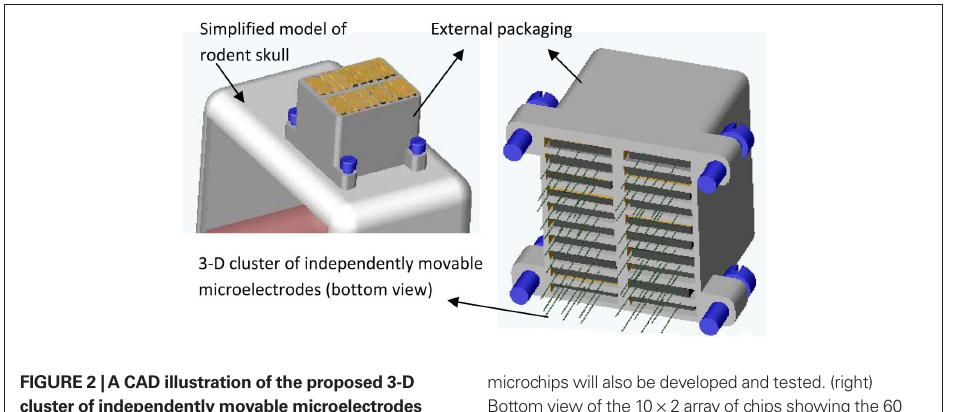
FigurE 2 | A CAD illustration of the proposed 3-D cluster of independently movable microelectrodes anchored on a simplified model of a rodent skull (in left). A 10 × 2 array of movable microelectrode chips (total of 20 chips each with 3 movable microelectrodes) is shown here but other layouts such as 3 × 5 and 3 × 7